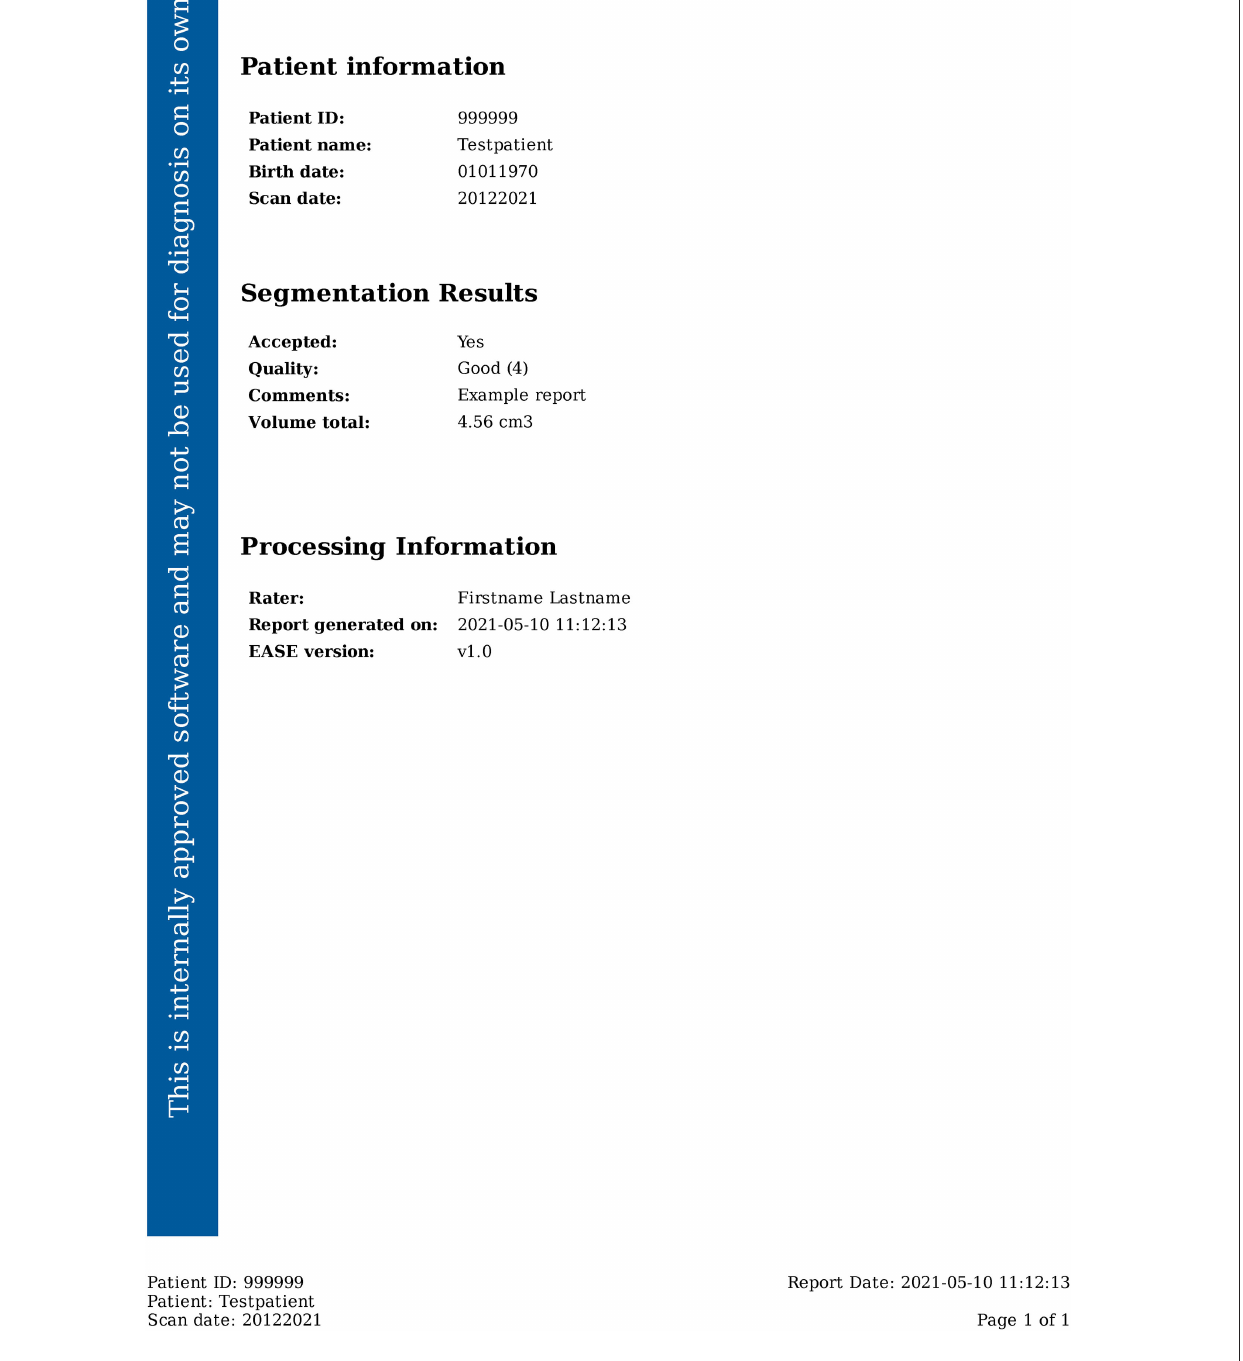
FIGURE 3 | Example of the EASE